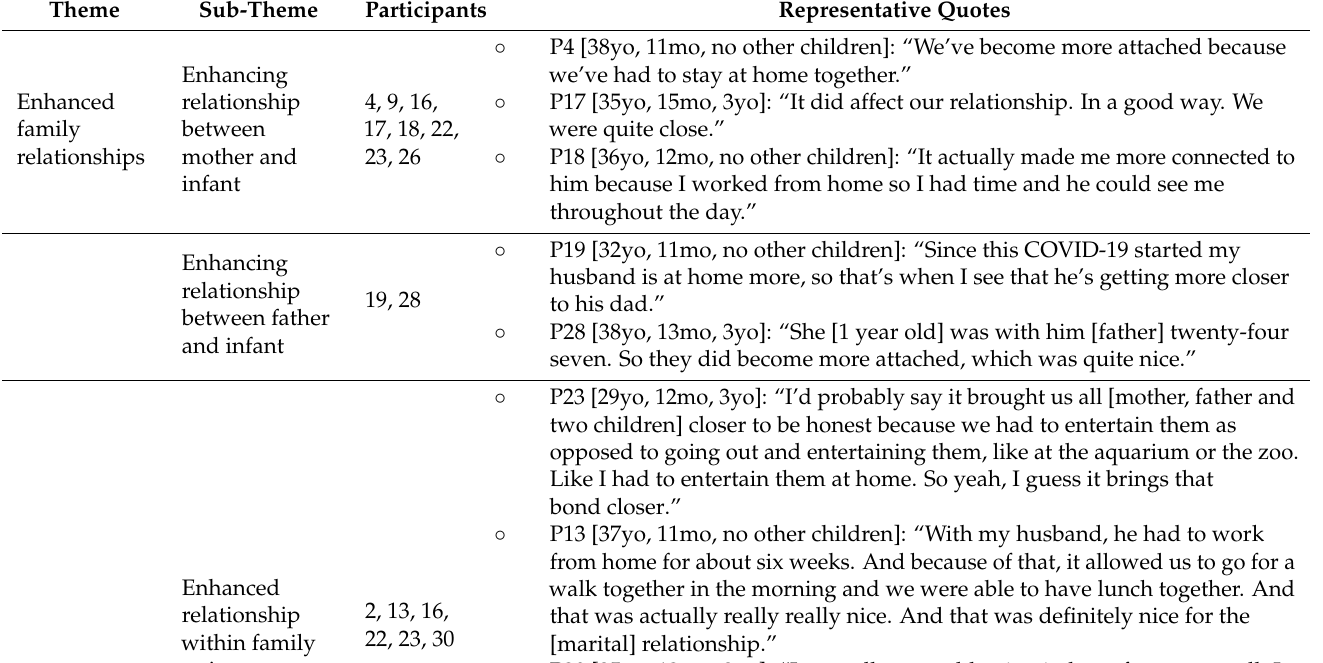
Table 2. Influence of COVID-19 on family interactions and